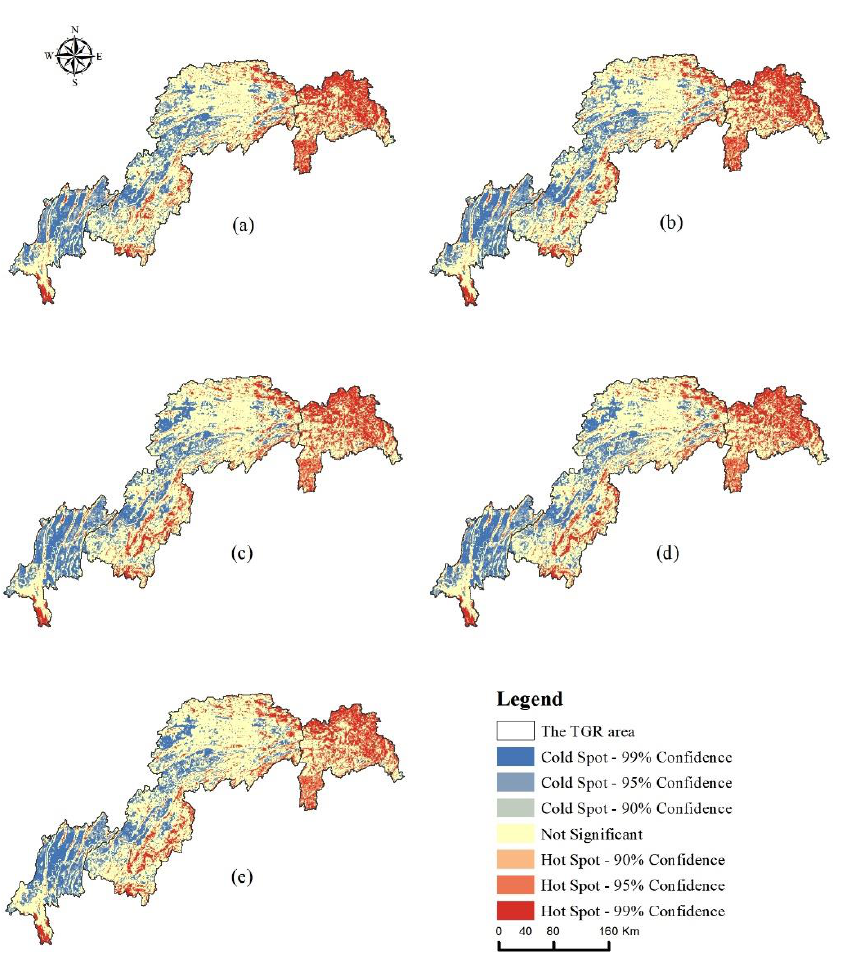
Figure 8. Spatial Distribution of Cold and Hot Spots of Habitat Quality in the TGRA (( a ) 2000, ( b ) 2005, ( c ) 2010, ( d ) 2015, ( e ) 2020).